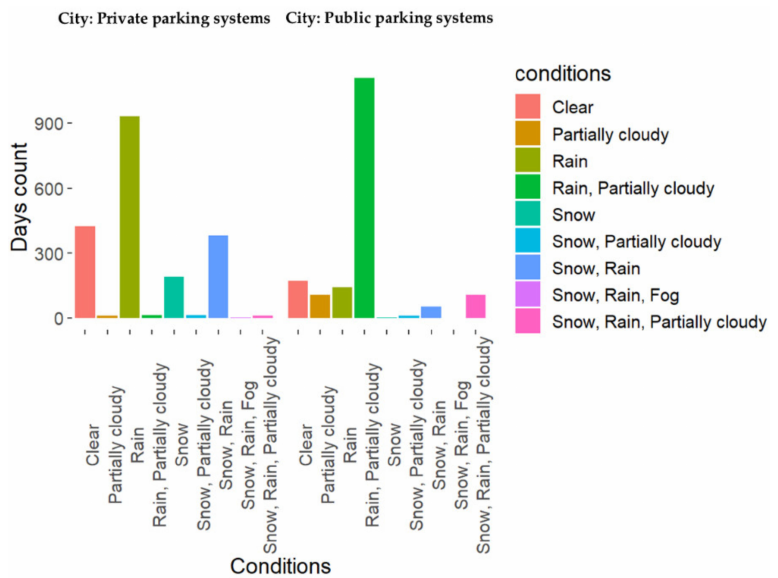
Figure 19. Weather data conditions for city for private parking systems ( left ) and for city for public parking systems ( right